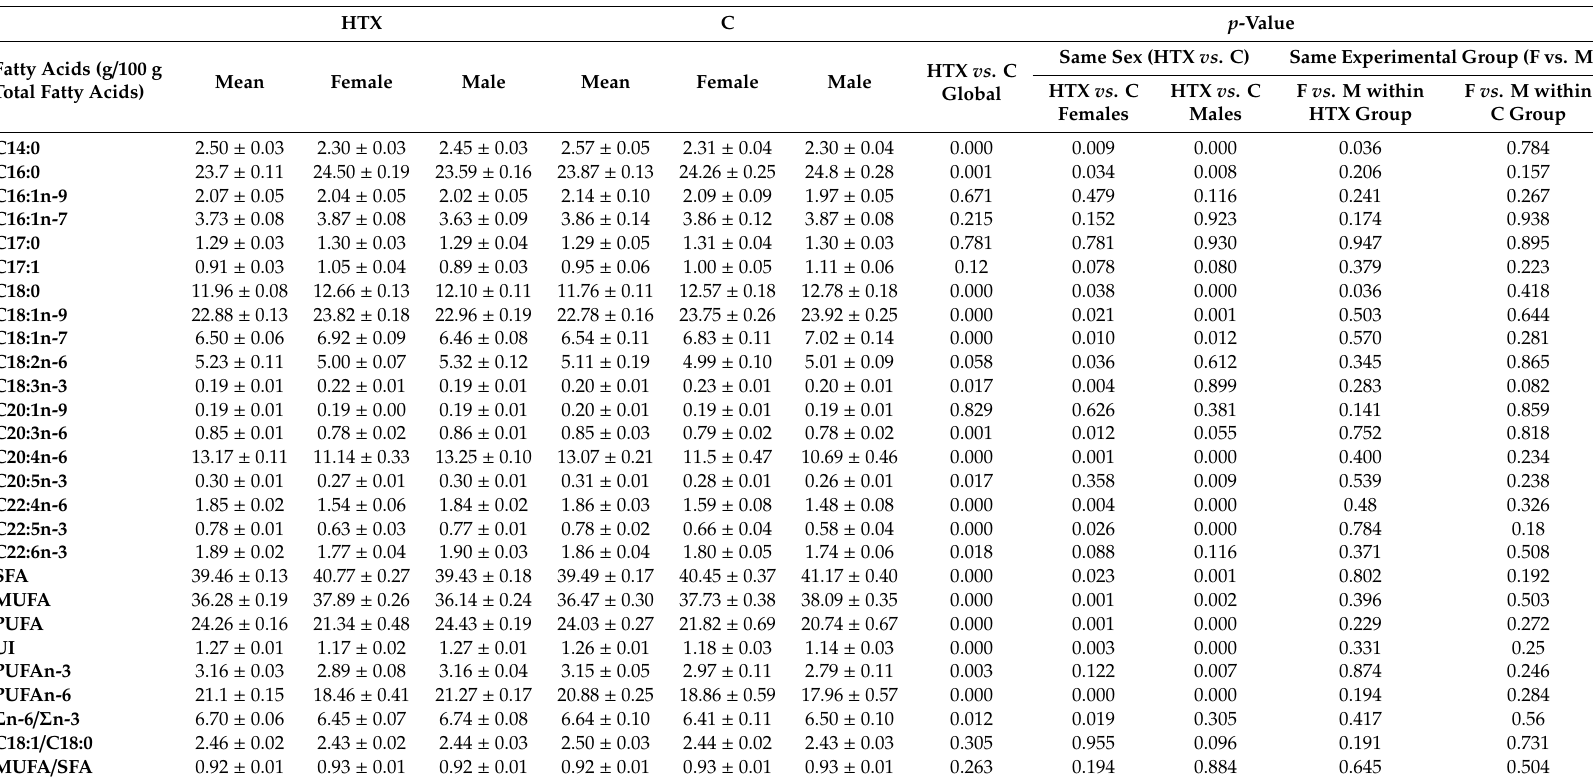
Table 5. E ff ects and di ff erences between sexes, of maternal hydroxytyrosol supplementation on the fatty acid profile of the fetal longissimus dorsi muscle. Mean values ( ± SEM) of polar lipids in female (F) and male (M) fetuses of the treated (HTX) and the control group (C). HTX C p -Value Fatty Acids (g / 100 g Mean Female Male Mean Female Male Total Fatty Acids)